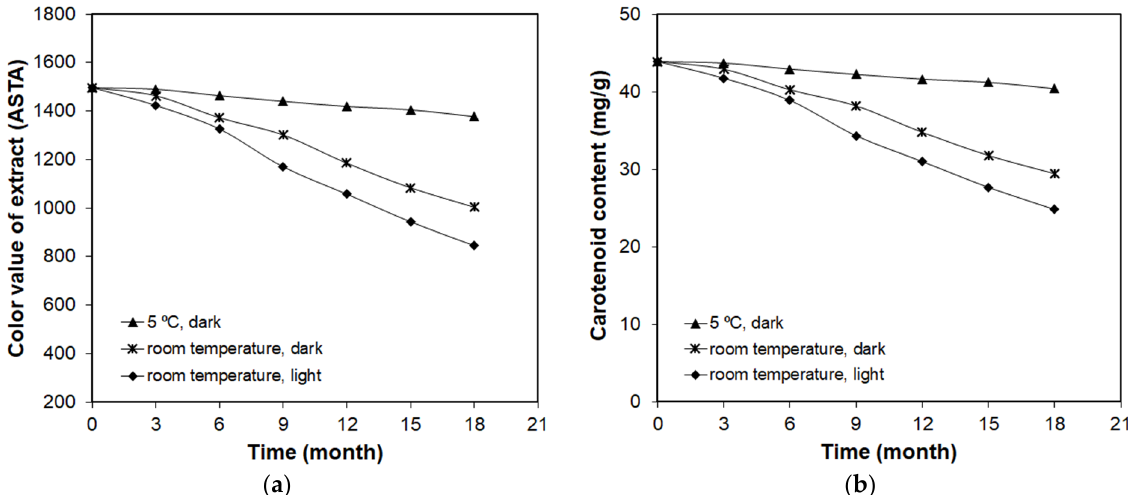
Figure 4. Effect of conditions and storage time on: ( a ) color value of extract; ( b ) total content of carotenoids in paprika extract.